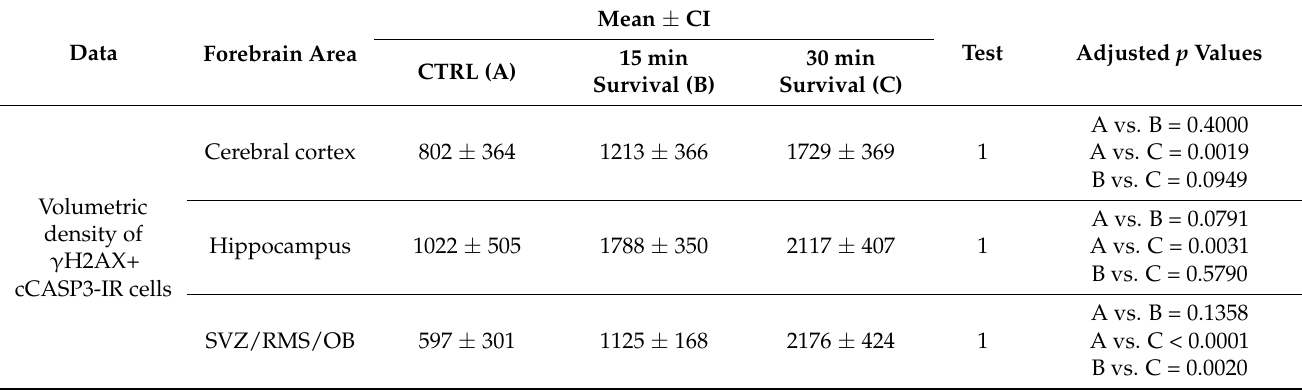
Table A4. Statistical analysis of volumetric densities and percentages of γ H2AX + cCASP3 immunoreactive cells. Legend : 1 = Kruskal-Wallis and Dunn’s multiple comparisons test. See Figure 11 for